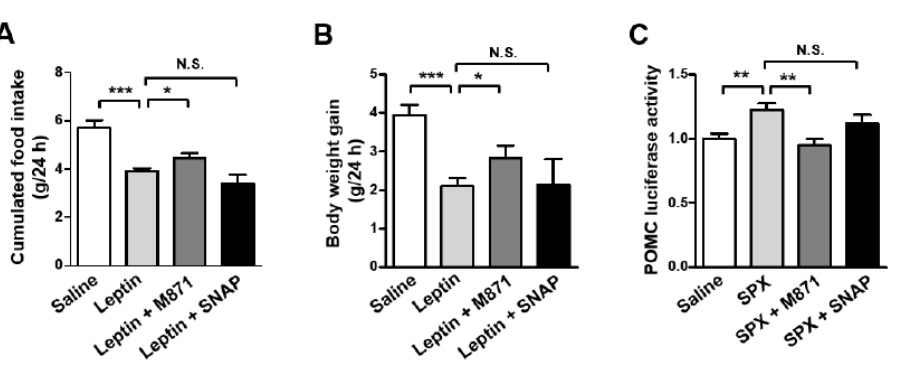
Figure 5. Anorexigenic effect of leptin-induced SPX via GALR2. ( A , B ) Eight-week-old male mice were fasted for 24 h and icv-injected with M871 (GALR2 antagonist, 5 nM) or SNAP (GALR3 antagonist, 5 nM) 1 h before icv leptin administration. Food intake ( A ) and body weight gain ( B ) were measured for 24 h after leptin injection. ( C ) Luciferase reporter constructs containing the 5′ -flanking region of POMC (300 ng) were transfected into mHypoA cells. After 24 h, cells were pre-treated with M871 (1 μM) or SNAP (1 μM) at 30 min before SPX (300 ng/mL) treatment. Then, cells were harvested for luciferase and β -galactosidase assays at 1 h after SPX treatment. Data are presented as mean ± S.E.M. *, p < 0.05; **, p < 0.01; ***, p < 0.001.